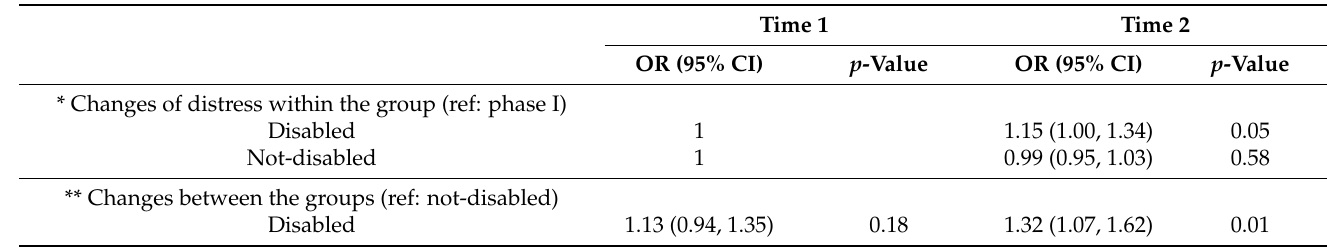
Table 4. Odds ratios and 95% CIs obtained from a GEE logistic regression model showing the changes in distress between disabled and